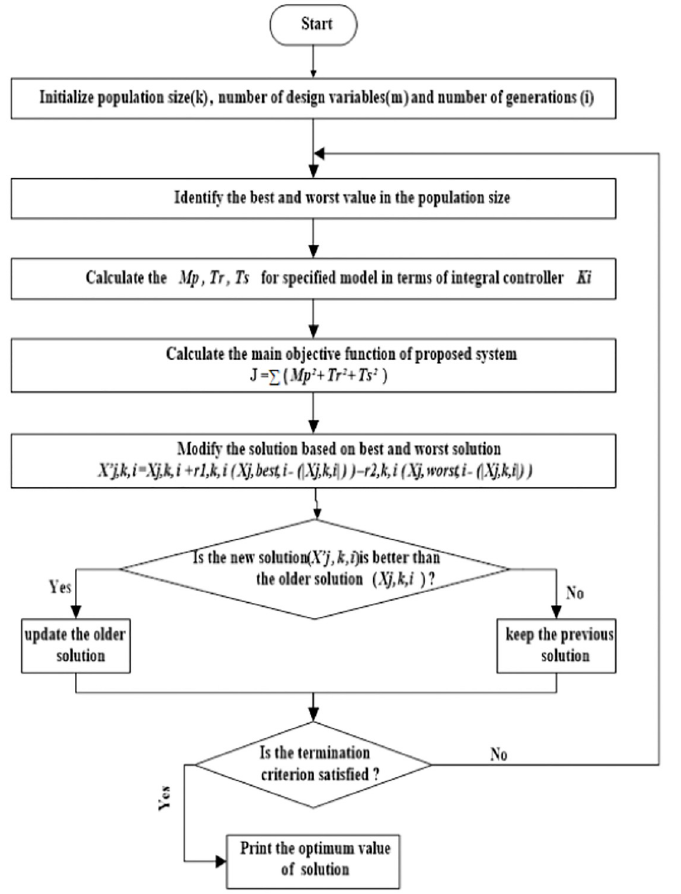
Fig 4. Flowchart of Jaya